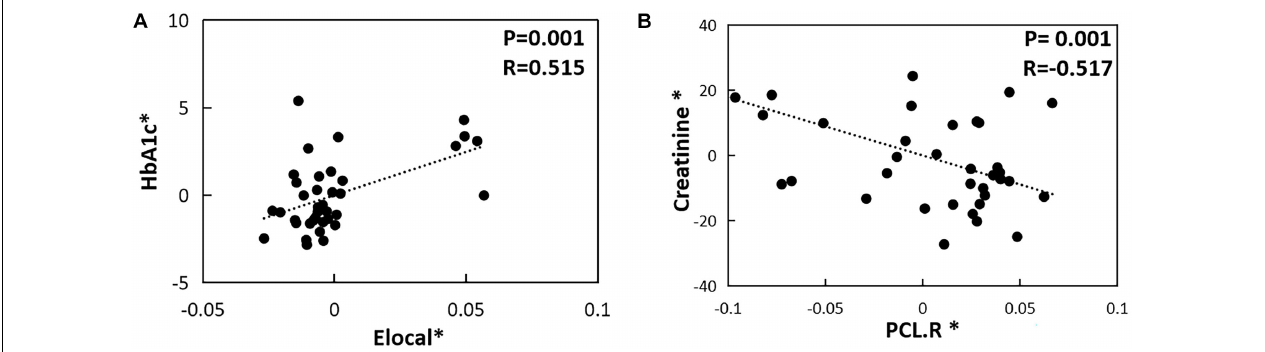
FIGURE 3 | The correlations between topological properties and cognitive/clinical variables. (A) Correlation between Eloc metrics and HbA1c level in the T2DM-C group ( P = 0.001, r = 0.515). (B) Correlation between NE values in the right PCL and serum creatinine values in the T2DM-C group ( P = 0.001, r = –0.517) The asterisk ( ∗ ) indicated coordinate values controlling for the influence of gender, age, and